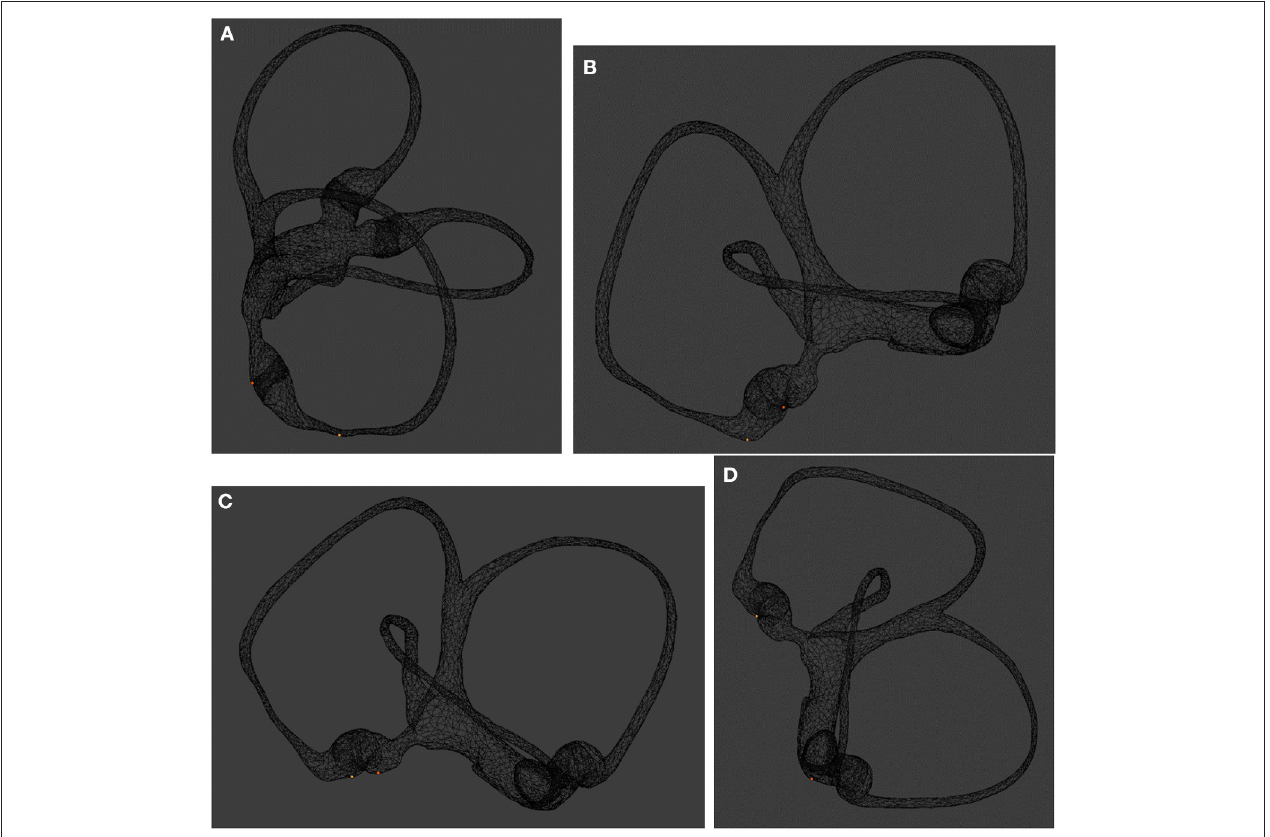
FIGURE 2 | Effect of the bow maneuver on otolith position. (A) Image taken with the patient sitting upright, back view. The otoliths are located on the short arm and long arm sides of the posterior semicircular canal. (B) Image taken with the patient’s head tilted forward 30 ◦ , lateral view; the otolith on the long-arm side moved closer to the ampulla. (C) Image taken with the patient’s head tilted forward 60 ◦ , lateral view. The otolith enters the ampulla and reaches the bottom of the crista ampullaris. (D) Image taken with the patient’s head tilted forward 120 ◦ , lateral view. The otolith on the short arm side of the posterior semicircular canal can exit the short arm and enter the